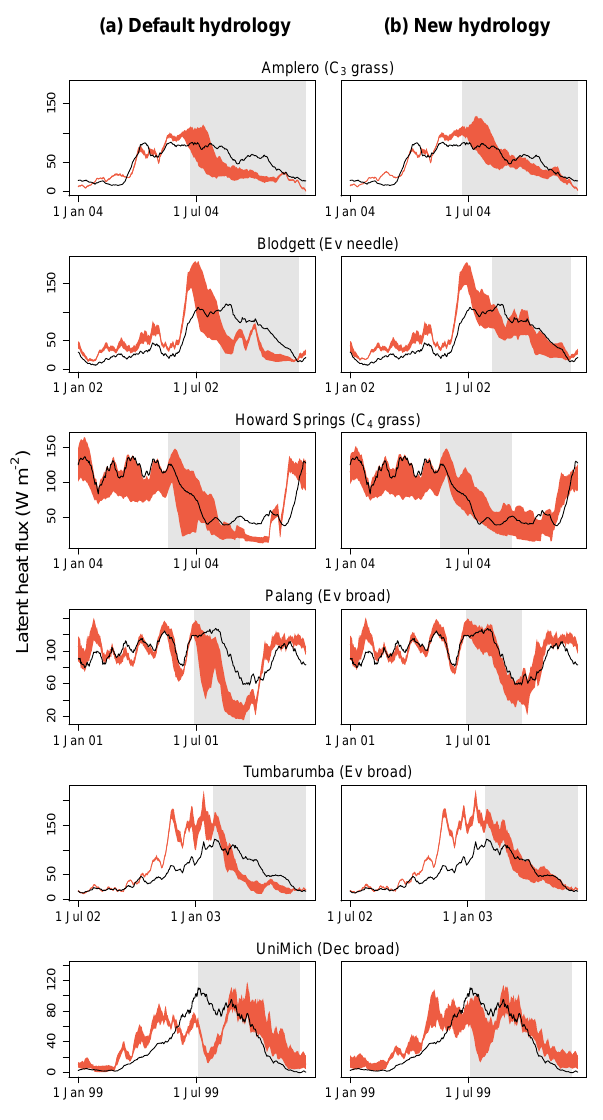
Figure 5. The range in simulated latent heat (red) during the 1-year period using the default (left panel) and new (right panel) hydro- logical schemes with alternative LAI, g s and soil parameterisations. Observed latent heat is shown in black. The grey shading denotes the selected dry-down period. All time series run from January to December, except Tumbarumba, which runs from July to the fol- lowing